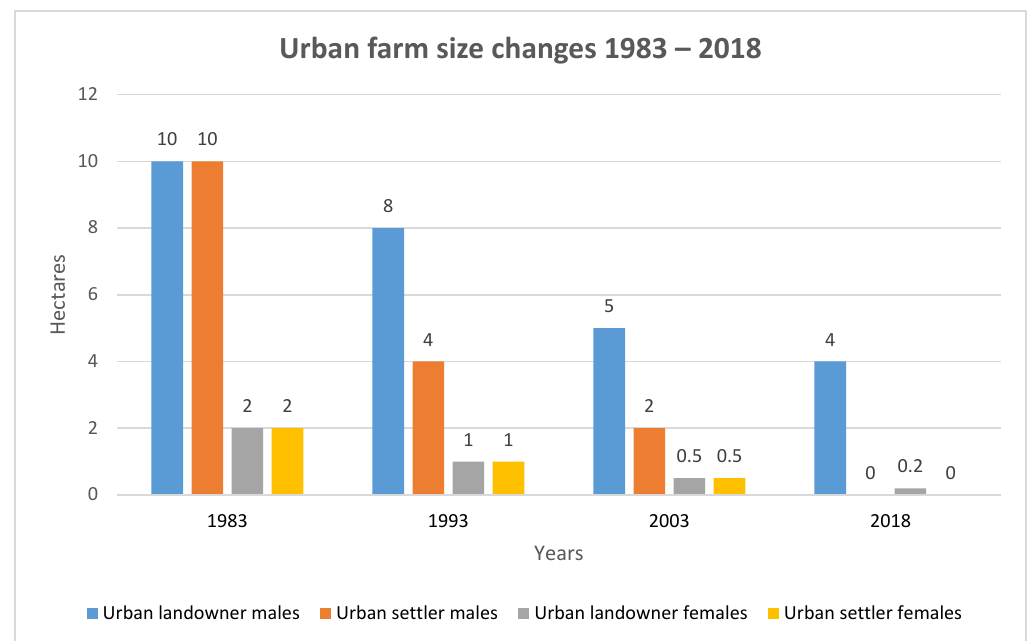
Figure 2. Changing farm sizes in peri urban portions of the study area – Sing & Kunfabiala near Wa. Regarding temporal inequalities of farm sizes among farmers, there is a downward trend in farm